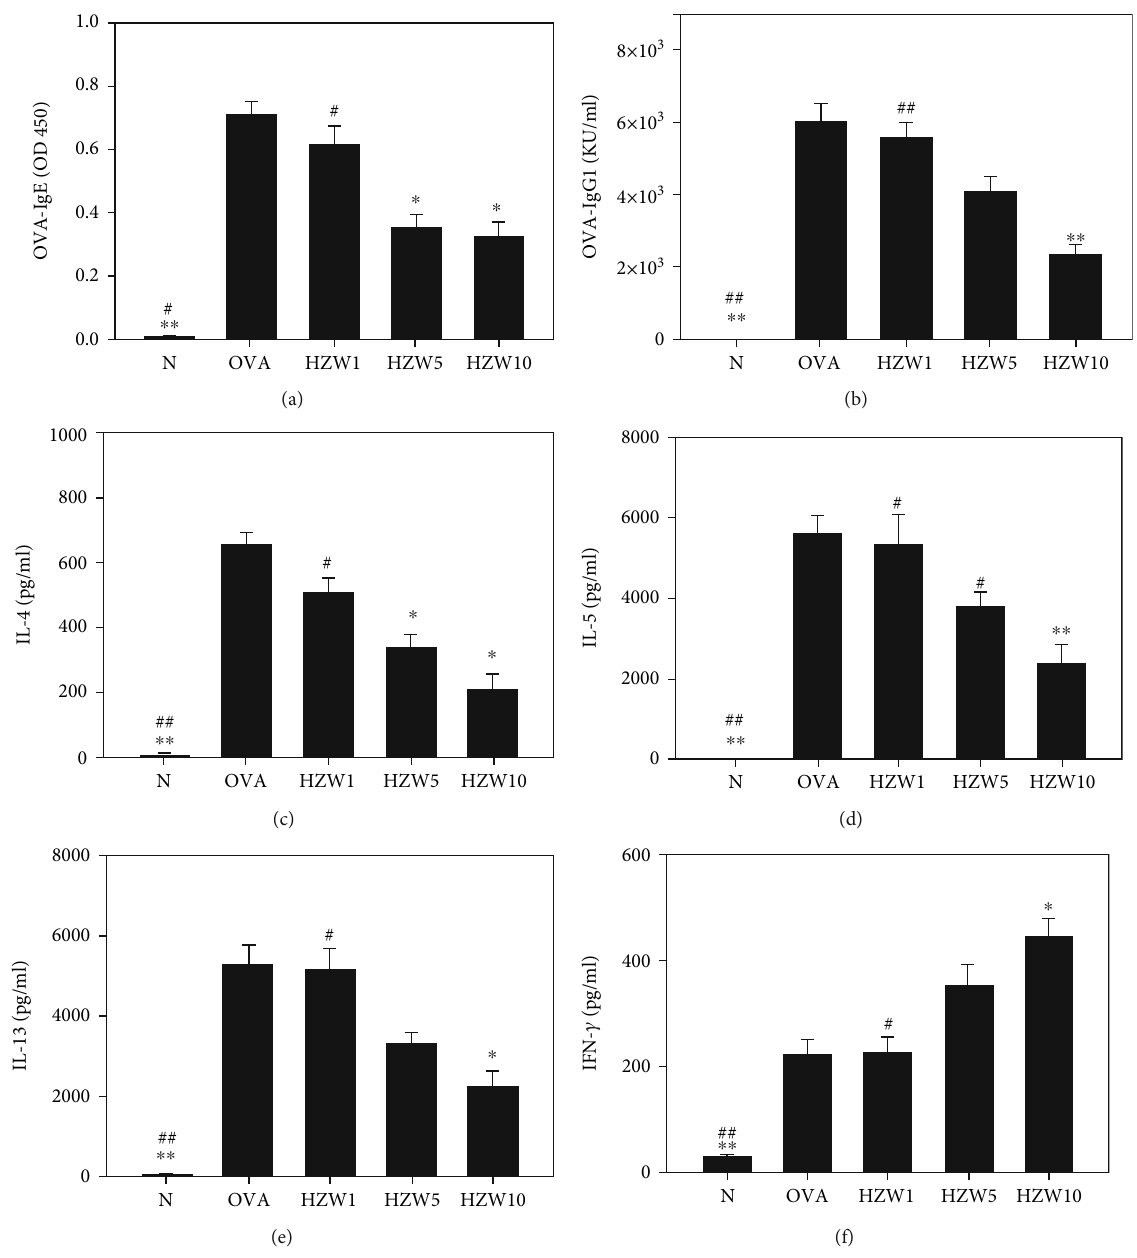
Figure 10: E ff ect of HZW on the levels of the OVA-speci fi c antibodies and cytokines. HZW reduced the levels of OVA-IgE (a) and OVA- IgG1 (b) in serum as well as IL-4 (c), IL-5 (d), IL-13 (e), and IFN- γ (f) produced by OVA-activated splenocytes. All data are presented as the mean ± SEM . ∗ P < 0 : 05 and ∗∗ P < 0 : 01 compared with the OVA control group. # P < 0 : 05 and ## P < 0 : 01 compared to the HZW10